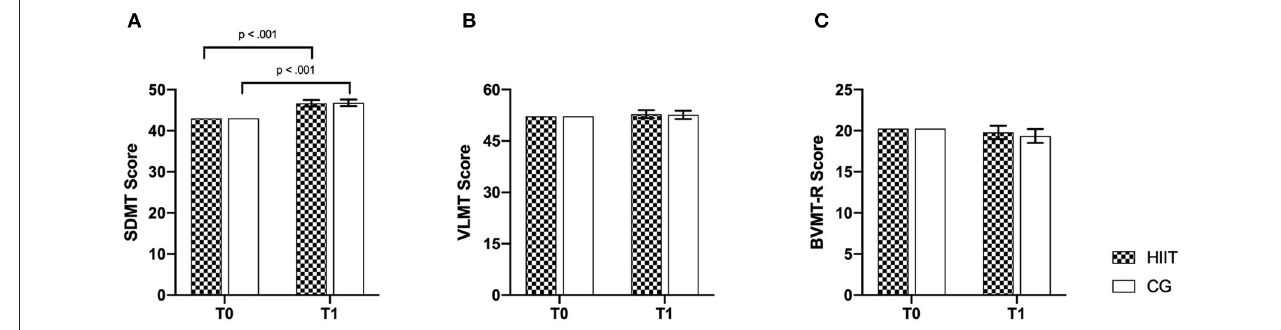
FIGURE 3 | Baseline-adjusted ANCOVA results for cognitive performance parameters for the intervention (HIIT) and control group (CG). T0, baseline; T1, post-intervention. (A) SDMT, Symbol Digit Modalities Test; (B) VLMT, Verbal Learning Memory Test; (C) BVMT-R, Brief Visuospatial Memory Test-Revised. Deviation bars are shown as standard error. TABLE 3 | MANOVA results of the subgroup analysis (impaired cognition vs. intact cognition). Descriptive